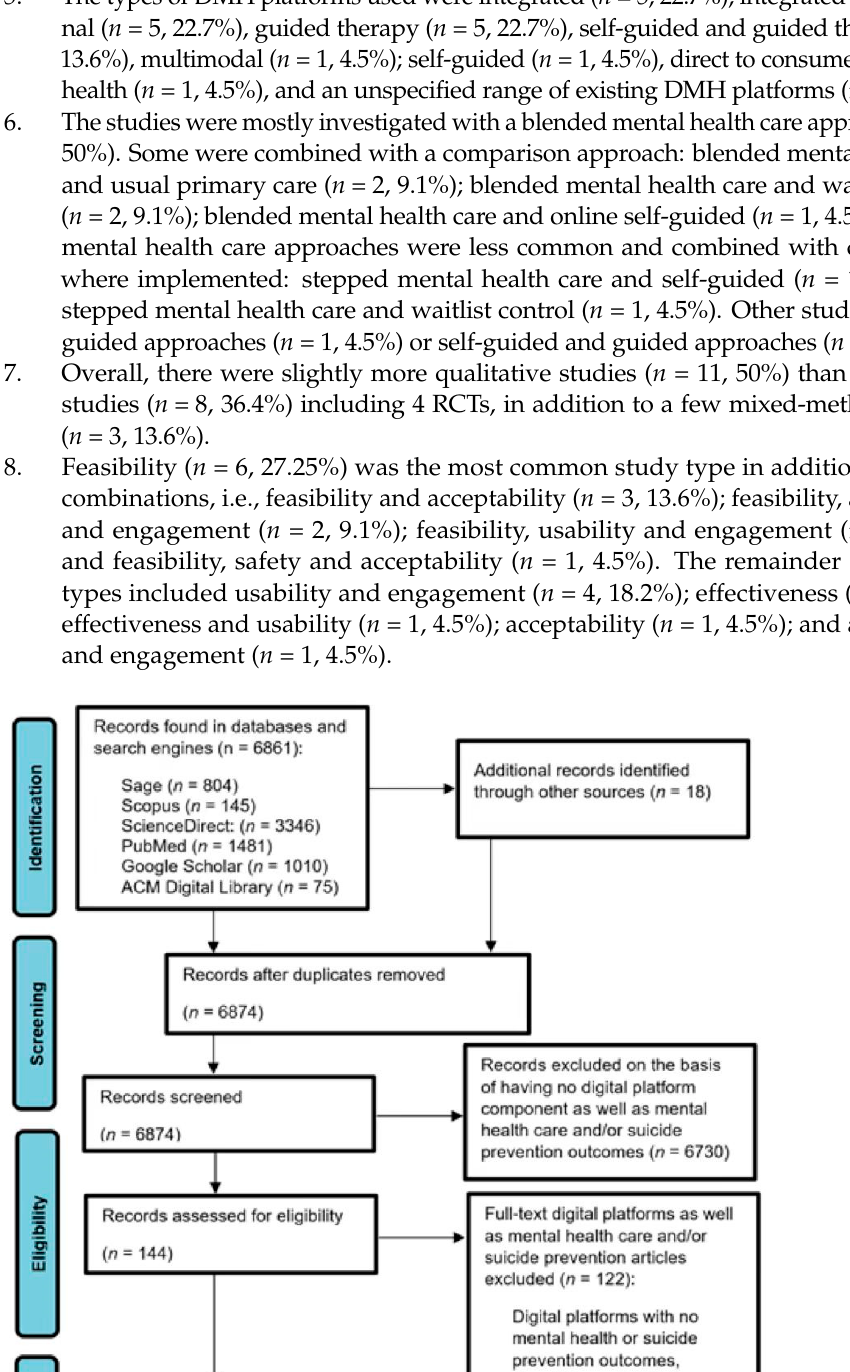
Table 1. Overview of empirical studies that focused on evaluation of the DMH platform/s used. Ref- ere- nce